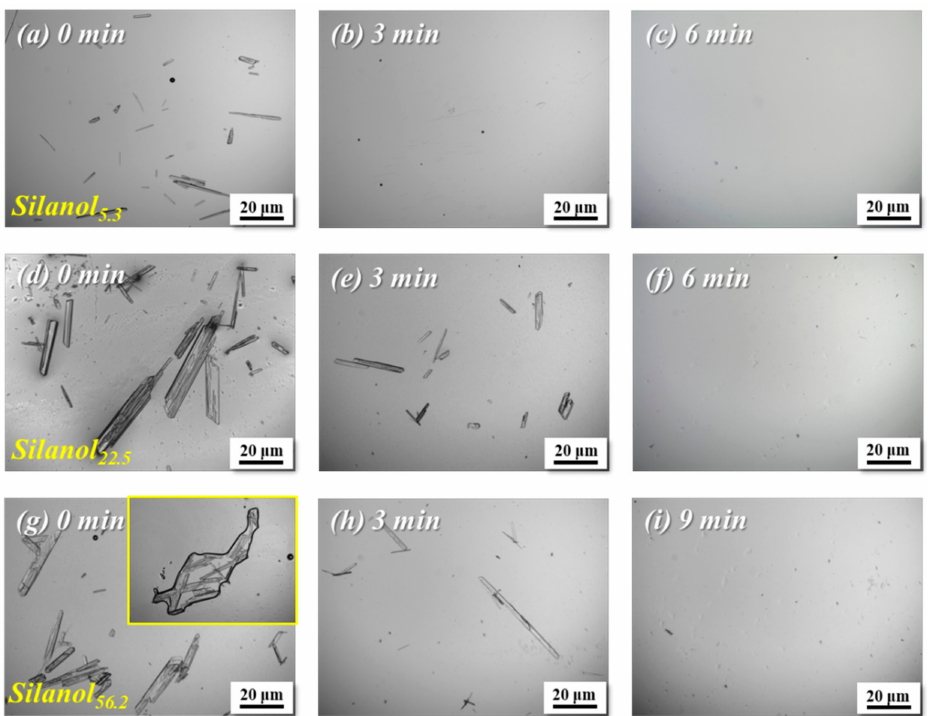
Figure 5. OM photographs of transesterification products of DPC/Silanol 5.3 reacted for ( a ) 0 min, ( b ) 3 min and ( c ) 6 min, DPC/Silanol 22.5 reacted for ( d ) 0 min, ( e ) 3 min and ( f ) 6 min and DPC/Silanol 56.2 reacted for ( g ) 0 min, ( h ) 3 min and ( i ) 9 min at 180 ◦